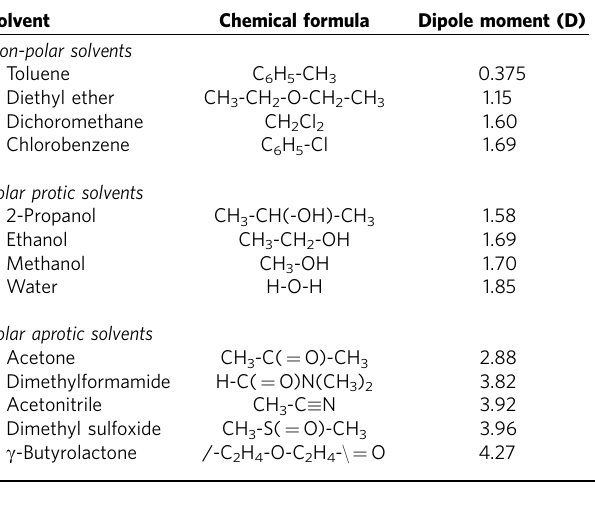
Table 1 | Various solvents used for the selective dissolution of the perovskite layer and their dipole moments.